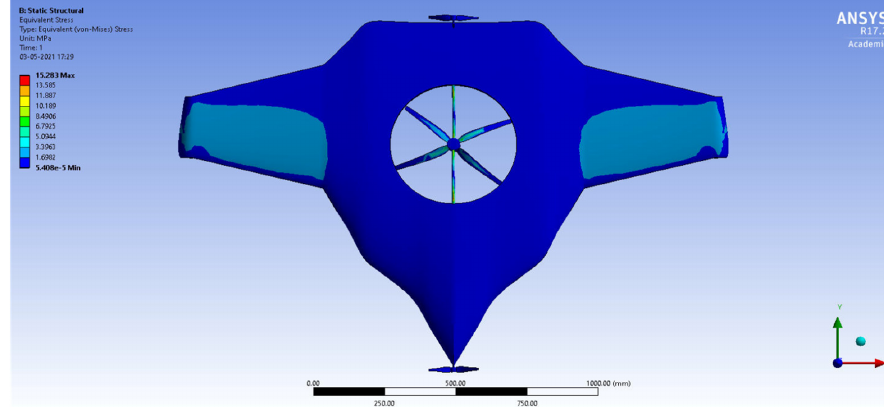
Figure 12. Total deformation.